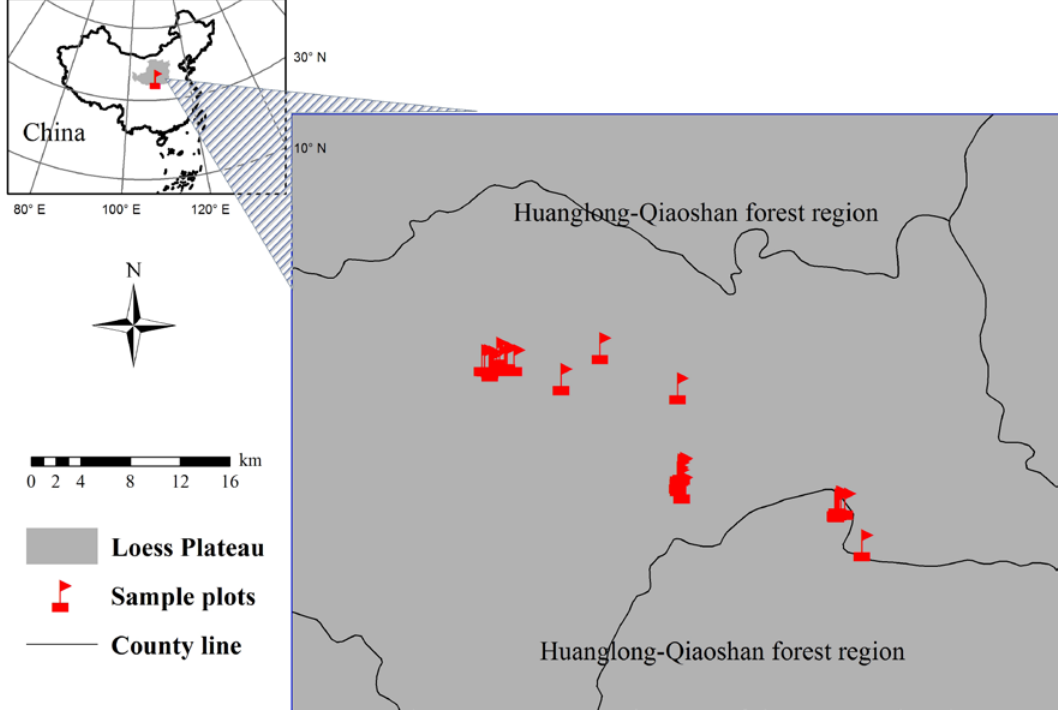
Figure 1. Representation of the study